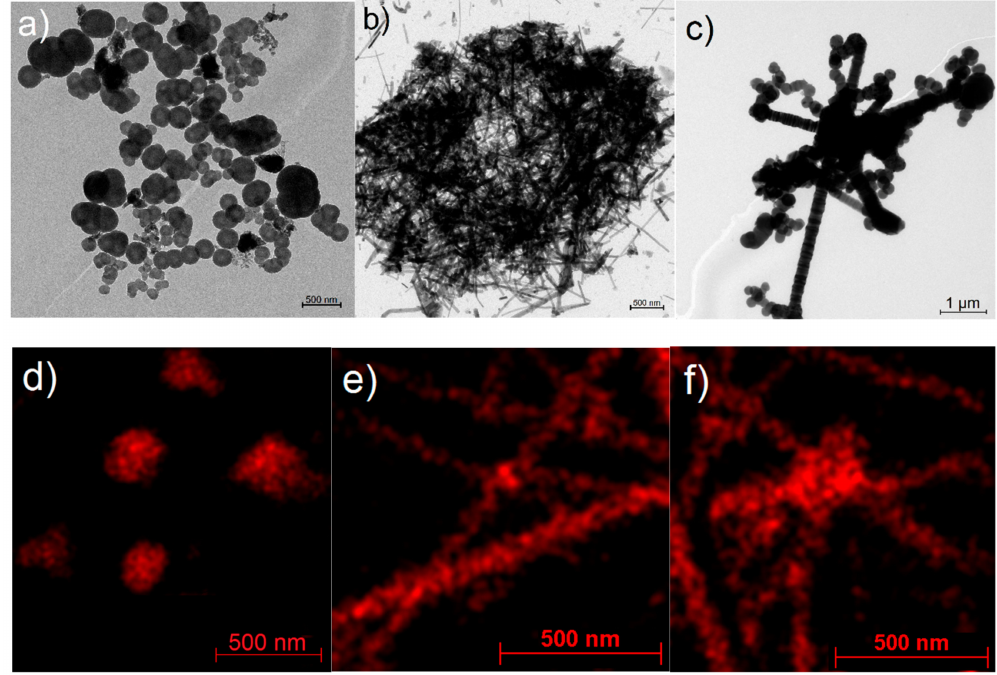
Figure 8. TEM images and Al EDS mappings of ( a , d ) round-shape, ( b , e ) rod-shape and ( c , f ) combined round/rod shape